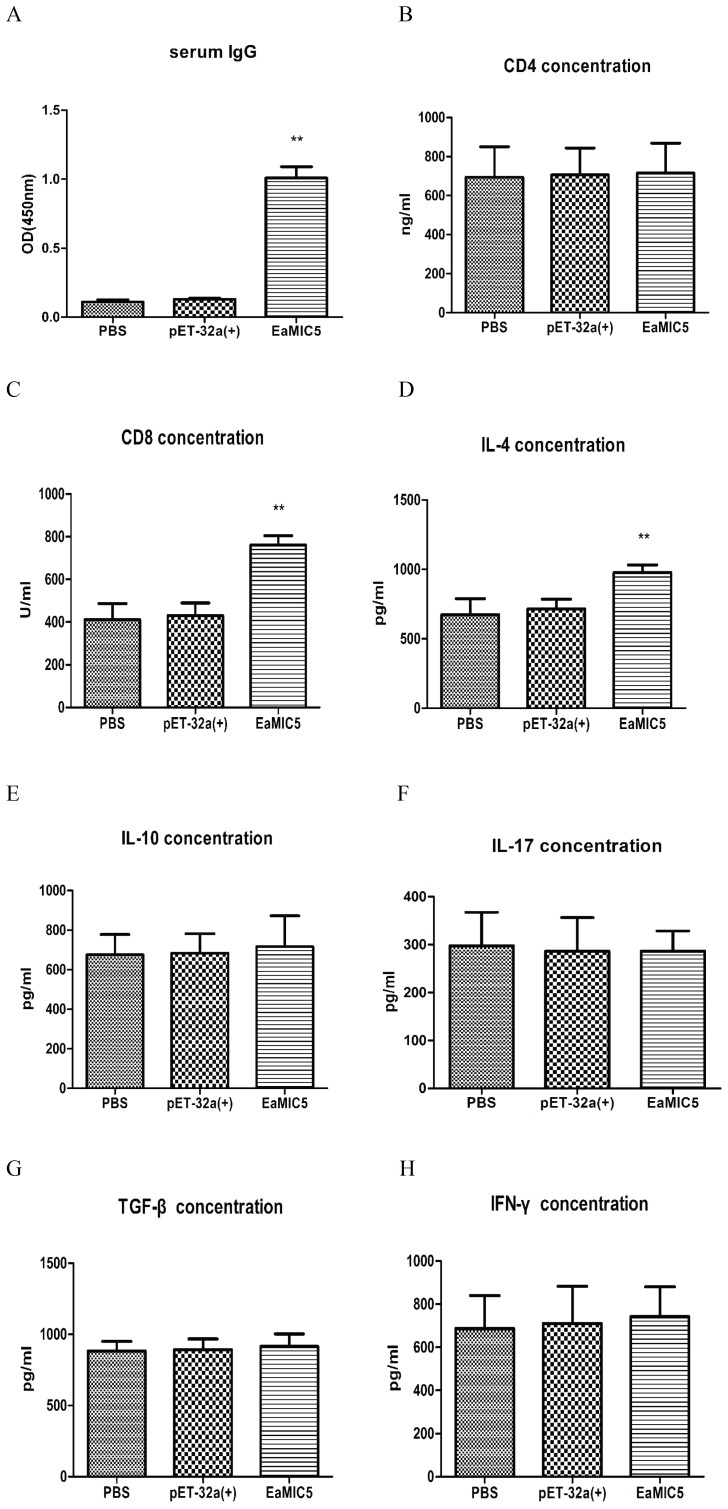
Serum EaMIC5-specific IgG, the concentrations of CD4, CD8 and cytokine levels in chickens.Chickens were immunized intramuscularly with PBS (negative control), pET-32a protein (pET-32a control), recombinant EaMIC5 protein. The IgG titers and the concentration CD4, CD8 and cytokine are expressed as mean ± SD with respect to absorbance at 450 nm. One star on the bar is slightly different from others, and two stars are significantly different (p<0.05), otherwise no different (p>0.05). A: IgG; B: CD4; C: CD8. D: IL-4; E: IL-10; F: IL-17; G: TGF- β and H: IFN-γ.